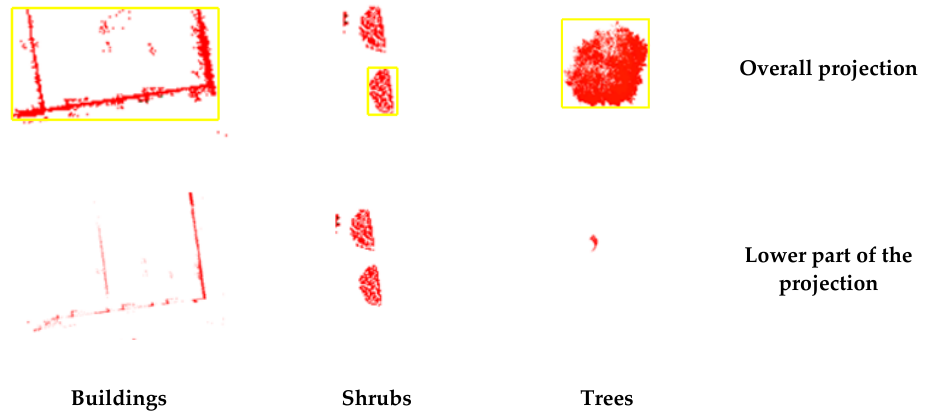
Figure 2. Projection differences of different ground objects (the yellow border represents the outer rectangle of the clusters).